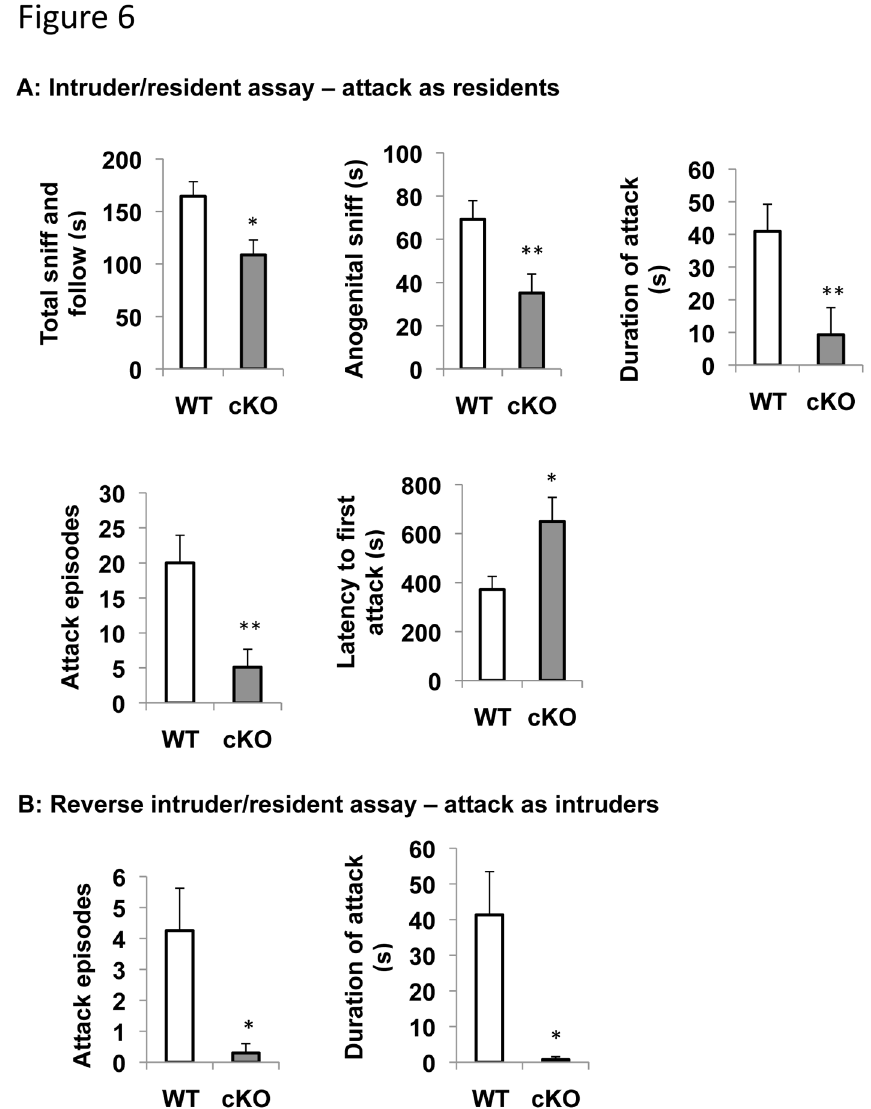
Figure 6. ERK cKO male mice are deficient in male-male aggression. A , A standard intruder-resident assay was conducted by introducing a sexually naïve normal SV129 male mouse into the home cage of a test male mouse. Both investigative (total sniffing and following, anogenital sniffing) and aggressive behaviors (duration of attack, attack episodes, latency to first attack) of the test male mice were quantified. B , A reverse intruder-resident assay was conducted by introducing a test male mouse into the home cage of a sexually naïve normal C57BL/6 male mouse. The aggressive behavior (duration of attack, attack episodes) initiated by the male ERK5 cKO or WT mice toward the resident mice was quantified. *, p<0.05; **, p<0.01.